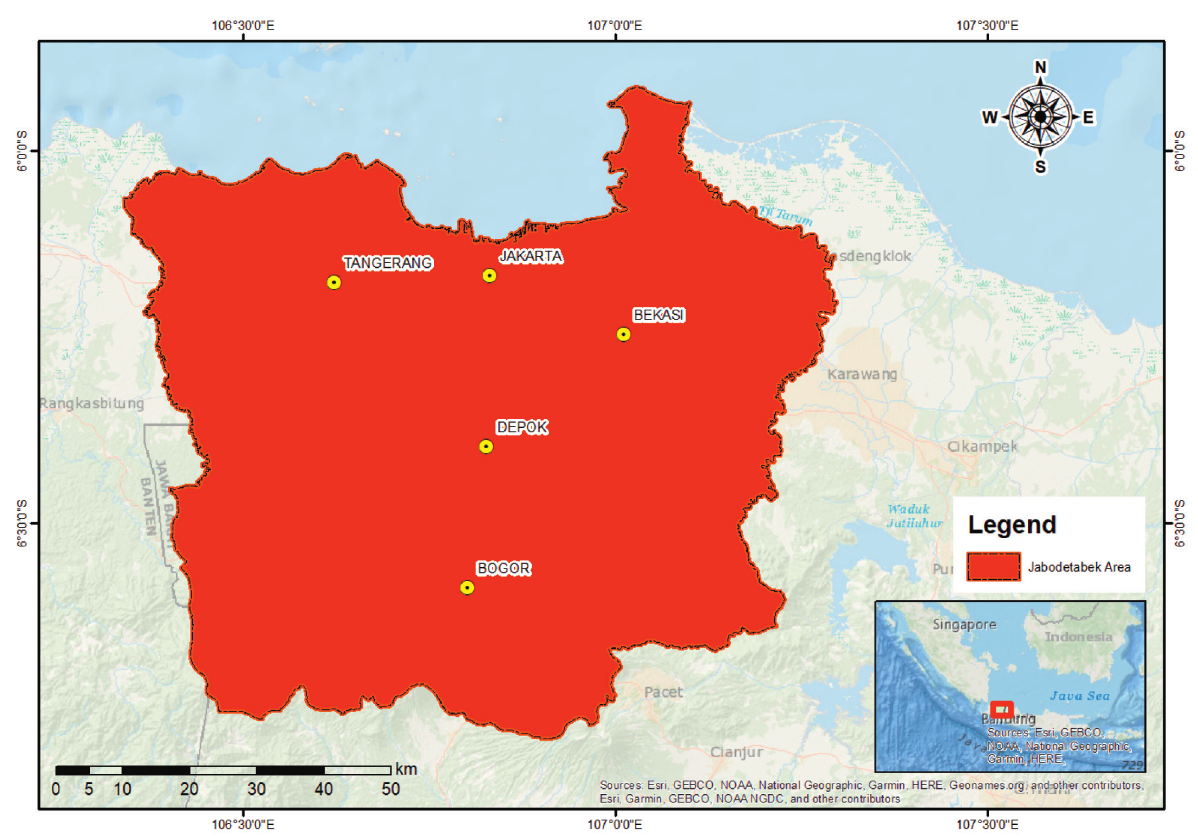
Figure 1: The study